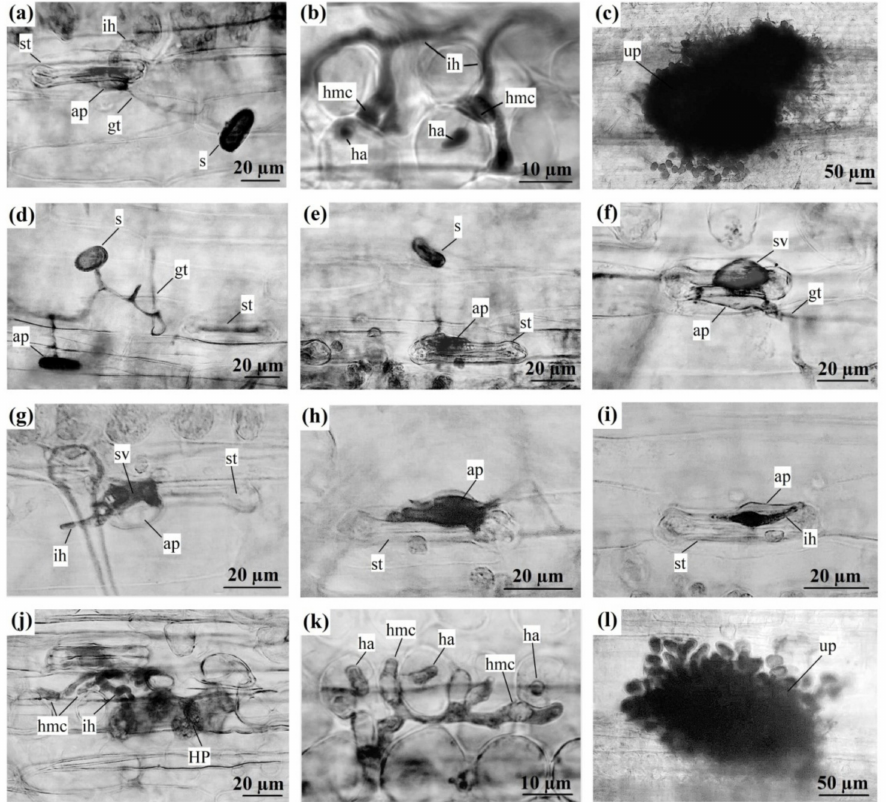
Figure 2. Development of infection structures of P. graminis f. sp. tritici on the wheat ( a – c , h – l ) and rye ( d – g ) plants: ( a )—germinated spore with growing tube and the empty appressorium on the stoma; ( b )—the part of colony with infection hyphae, HMCs and haustorium in tissue of susceptible cv. Pamyati Azieva; ( c )—urediniopustule on the cv. Pamyati Azieva; ( d )—germinated spore with grow- ing tube passed by the stoma and the appressorium on the surface of cv. Petkus; ( e )—appressorium full of cytoplasm on the stoma of cv. Petkus; ( f )—empty appressorium and substomal vesicle on rye cultivar; ( g )—empty appressorium and substomal vesicle with infection hypha on the surface of rye; ( h )—appressorium with destructed cytoplasm on the stoma of cv. Seri 82; ( i )—empty appressorium and substomal vesicle with infection hypha on cv. Seri 82; ( j )—small colony in cv. Bacanora with infection hyphae, HMCs and appearance of HR after haustoria penetration into cell; ( k )—small colony in cv. Bacanora with vacuolized infection hyphae, HMCs and haustorium; ( l )—urediniopustule on the cv.